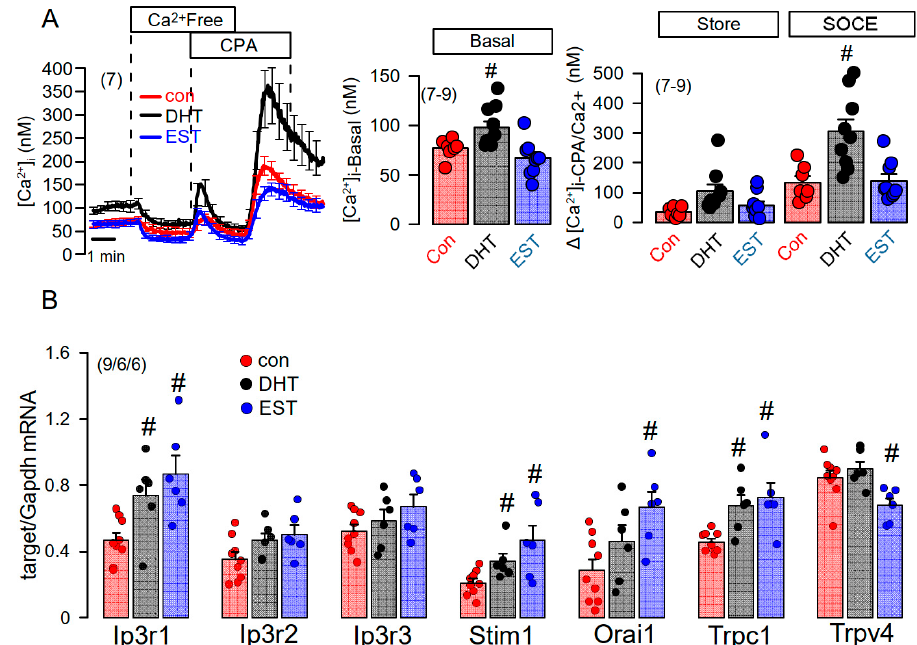
Figure 7. Effect of dihydrotestosterone and estrogen on intracellular Ca 2+ concentrations and expression of Ca 2+ -regulating proteins in mouse mCCDcl1 cortical collecting duct cells. ( A ) Summary time course of the effects of extracellular Ca 2+ -free buffer and cyclopiazonic acid (10 µM) on intracellular Ca 2+ concentrations in control mCCDcl1 cells and mCCDcl1 cells treated with dihydrotestosterone (DHT; 10 µM, 24 hrs) and estrogen (EST, 10 µM; 24 hrs). Summary of basal intracellular Ca 2+ concentration and changes in intracellular Ca 2+ induced by CPA (Ca 2+ store release through leakage channels; Store) and re-addition of Ca 2+ to the extracellular buffer (store operated Ca 2+ entry; SOCE). ( B ) RT-PCR analysis of the expression of Ca 2+ -regulating proteins and effects of DHT and EST. Mean ± SEM (number of experiments in each series). # Significant increase when compared with con ( p < 0.05; ANOVA).